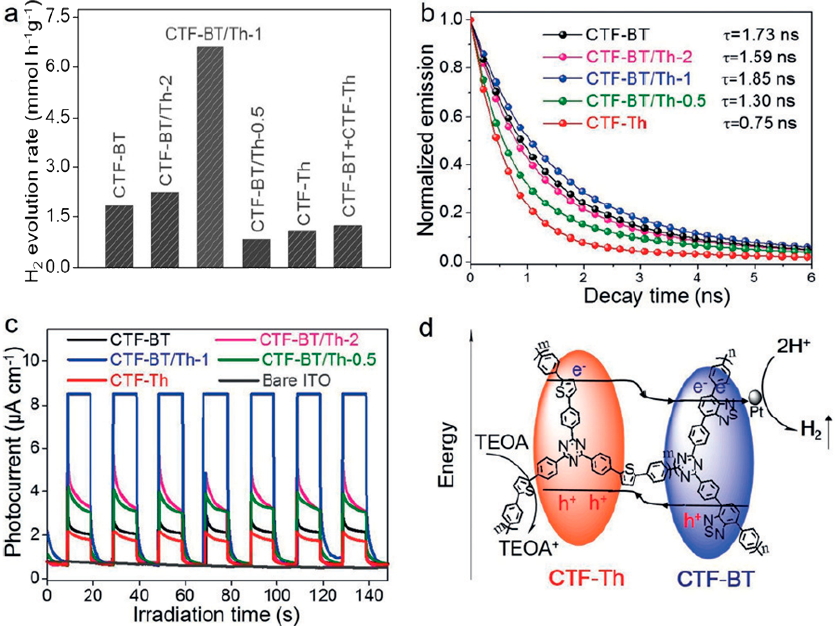
Figure 10. Photocatalytic activity for hydrogen evolution and efficiency of charge separation over a heterojunction photocatalyst of CTF-Th and CTF-BT [44]. ( a ) Photocatalytic activity for hydrogen evolution; ( b ) time-resolved photoluminance; ( c ) photocurrent responses and ( d ) illustration of the facilitated charge-carrier separation across the covalently interconnected molecular heterostructure.